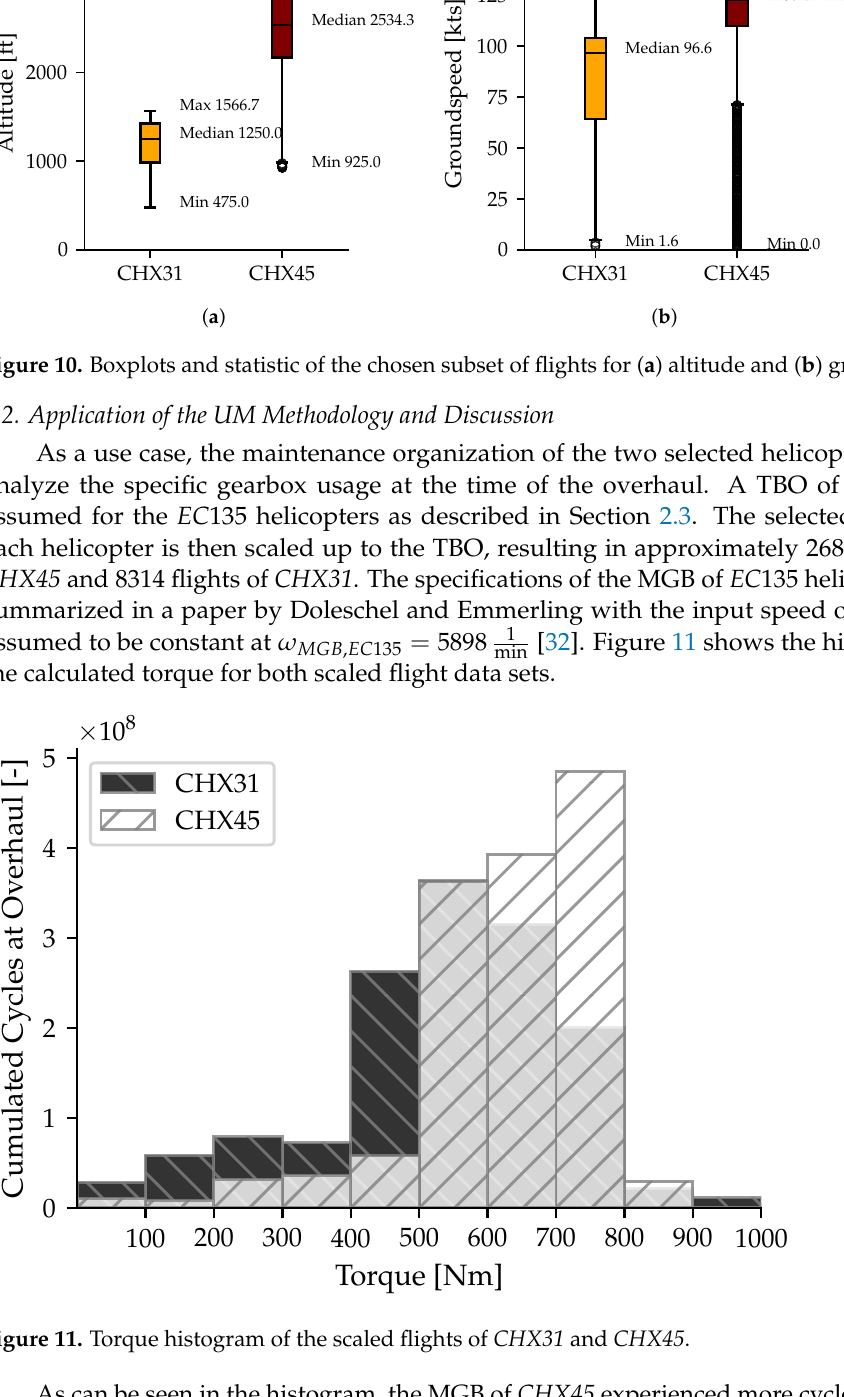
(b) Figure 12. The result of the usage analysis summarized as summed torque collective with UI and T eq for (a) CHX31 and (b) CHX45 .